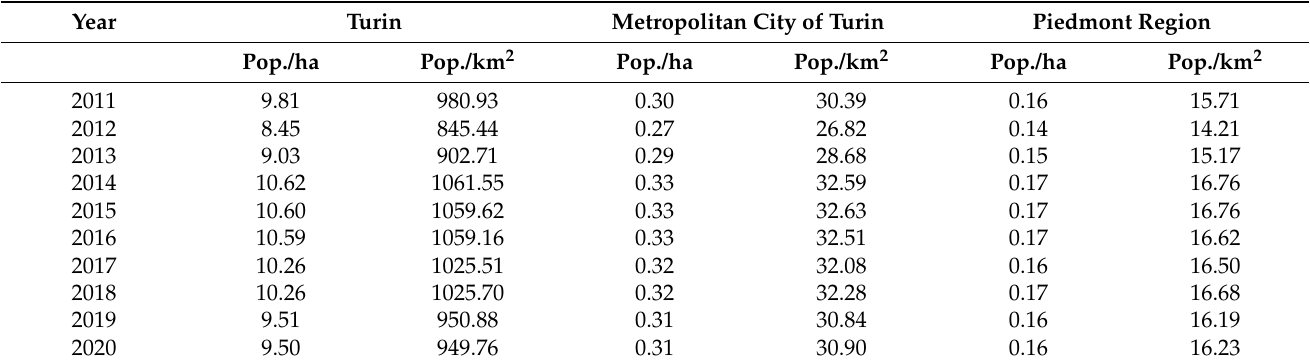
Table 9. Population density of the City of Turin, the Metropolitan City, and the Piedmont Region from 2011 to 2020 [44]. * Pop. = population.